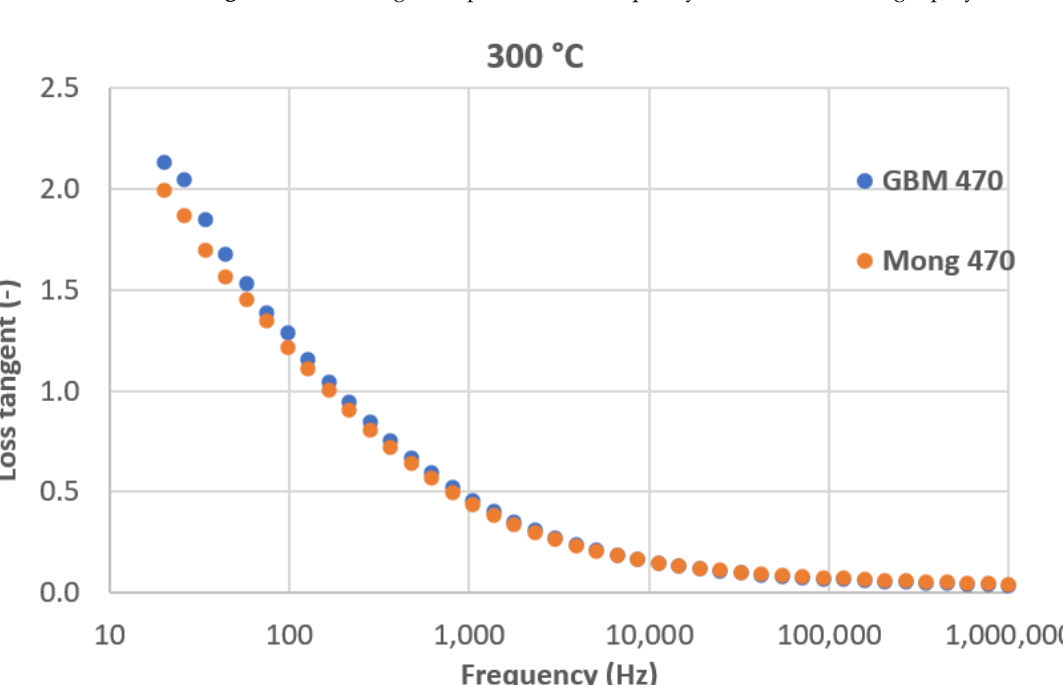
Coatings 2022 , 12 , x FOR PEER REVIEW